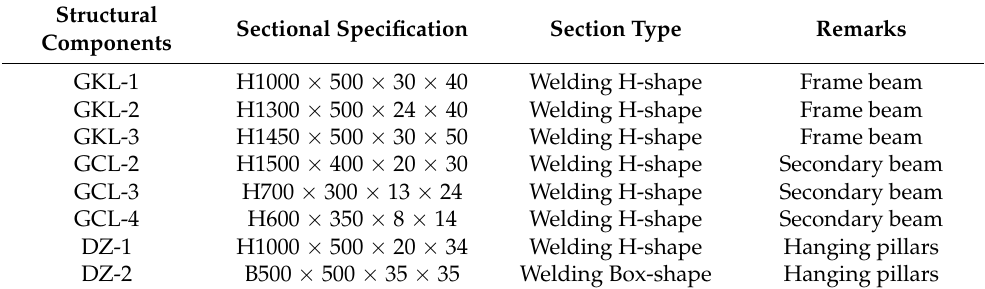
Figure 1. The suspended structure: ( a ) structural configuration; ( b ) details of the second-story suspended floor in zone B. Table 1. Component parameters of the second-story suspended floor in zone B.